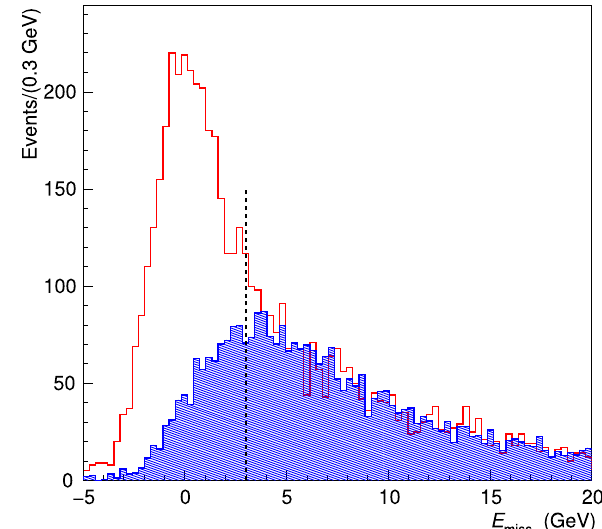
Fig. 4 The missing-energy distribution from experimental data (open histogram) compared to the distribution of SIDIS events from a LEPTO MC simulation (shaded histogram). The MC distribution is normalised to the data in the region 7 GeV < E miss < 20 GeV. The vertical dashed line denotes the upper limit of the exclusive region. Each LEPTO MC eventisreweightedbya E miss -dependentweightthatiscalculatedusing both experimental and simulated data with same-charge hadron pairs. See text for a detailed